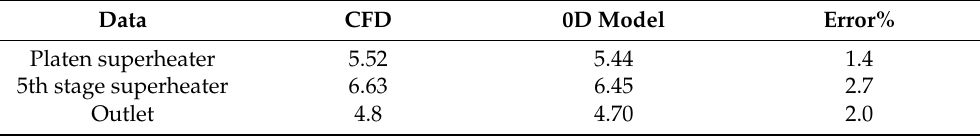
Table 8. Summary of the parameters of the verification results.